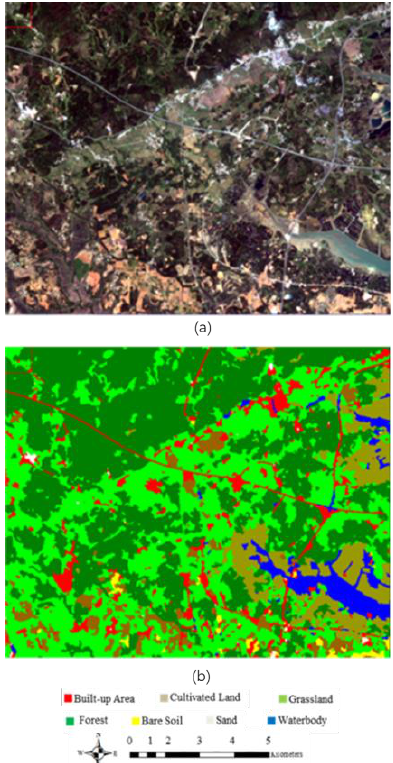
Figure 5. Clips of land cover extraction results for Beibuwan Gulf peninsula in 2017.